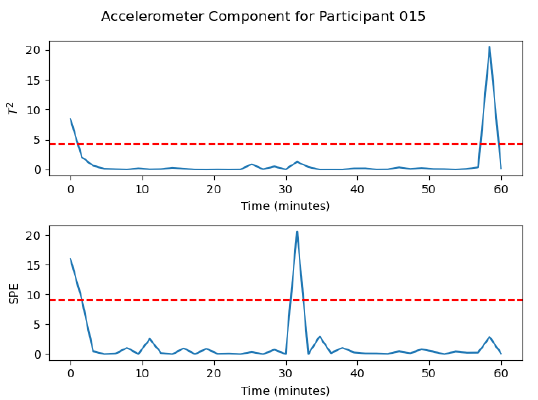
Figure 6. Participant 15 MSPC-PCA Analysis for the Accelerometer information.